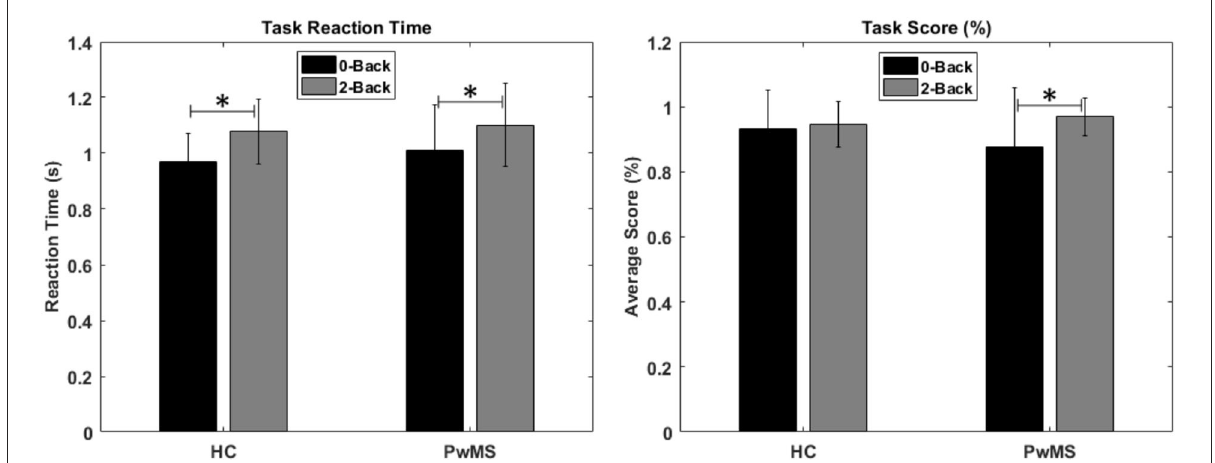
FIGURE3 Reaction time (s) and score percentage for the 0-back and 2-back tasks in the healthy controls and people with MS. There were no significant differences between the groups. Within each group, the reaction time of the 2-back task was higher when compared to 0-back. PwMS also scored higher in the 2-back when compared to the 0-back task (* p < 0.05).